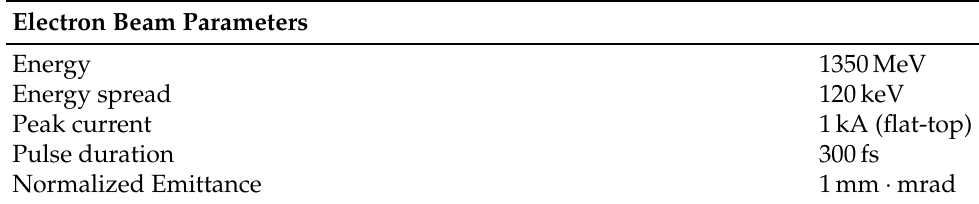
Table 1. Electron beam parameters used in